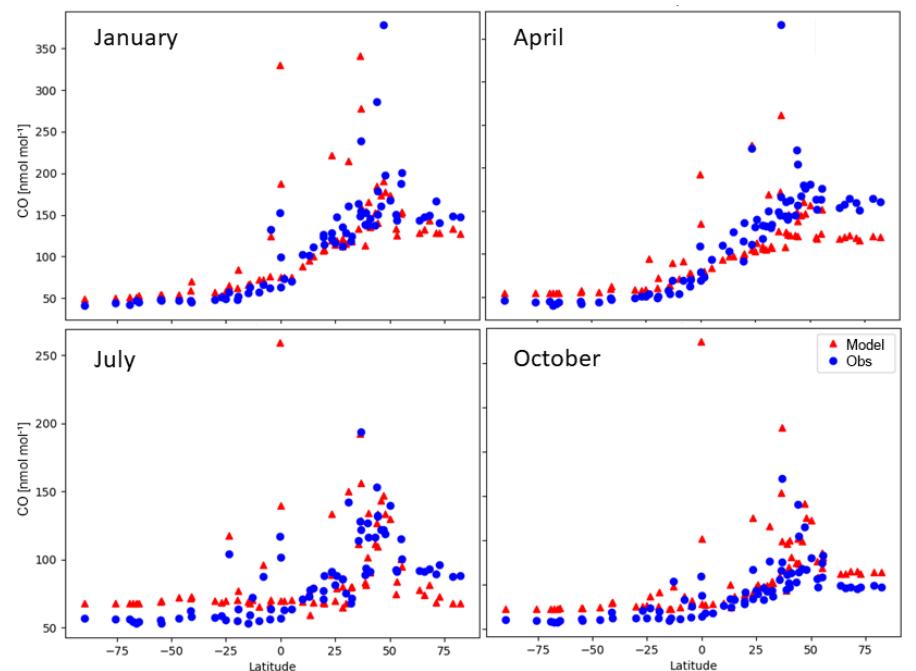
Figure 11. Comparison of monthly mean surface CO measurements from GAW with ECHAM-HAMMOZ base run results for January, April, July, and October 2008. Each symbol represents data from one measurement location.